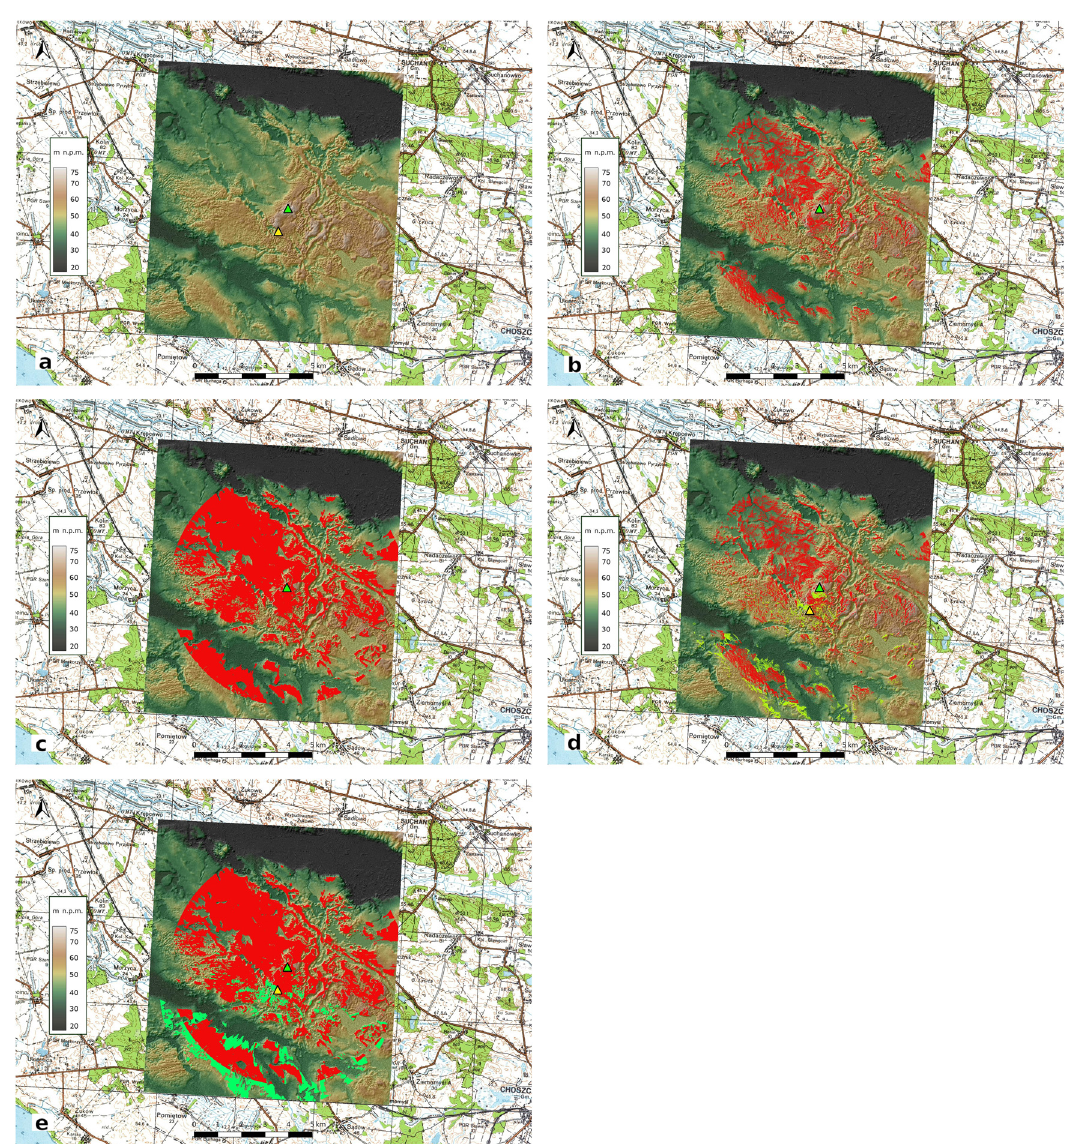
Figure 10: The point selected as optimal near the Dolice - Rondo Lucjana megalithic group ( yellow triangle ) in terms of visibility from this location and this location from the surrounding area: location of the point [ green triangle ] ( a ) , the area visible from the point ( b ) , the area from which the point is visible ( c ) , the juxtaposed areas visible from the point and the tombs of the Dolice - Rondo Lucjana megalithic group ( d ) and the juxtaposed areas from which the point and the tombs of the Dolice - Rondo Lucjana megalithic group are visible ( e ) ( M. Schiller )